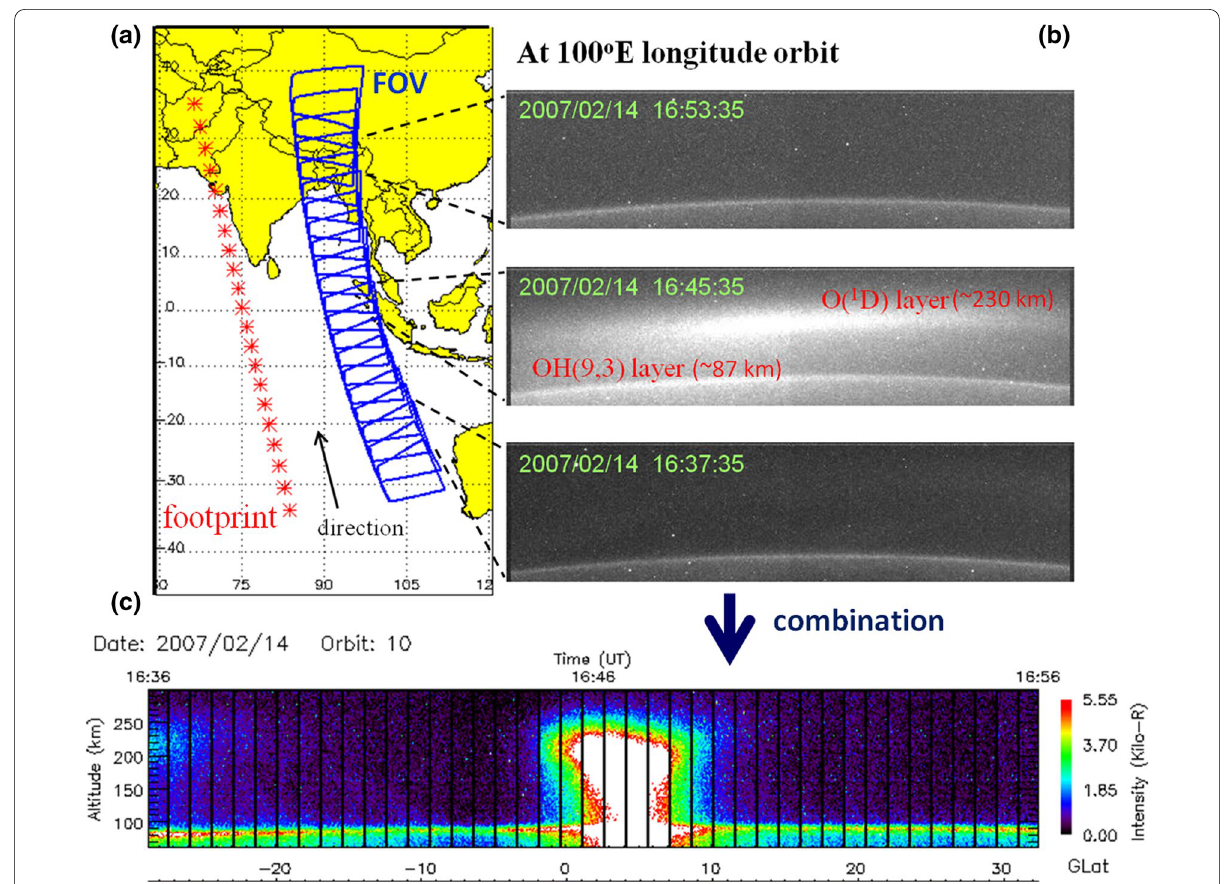
Fig. 1 a Ground projection of the satellite tracks (red stars) and the corresponding FOV (blue lines) for a typical observation in an orbit; b three typical ISUAL 630.0 nm images taken in the night of 14 Feb., 2007, corresponding to the FOV in a ; c a combined image for the orbit shown in